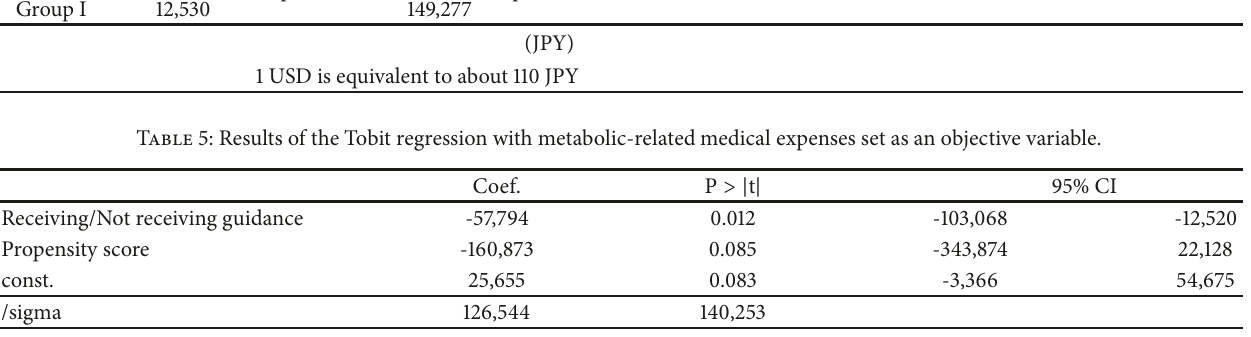
Table 6: Results of the Tobit regression with other medical expenses set as an objective variable. Coef.